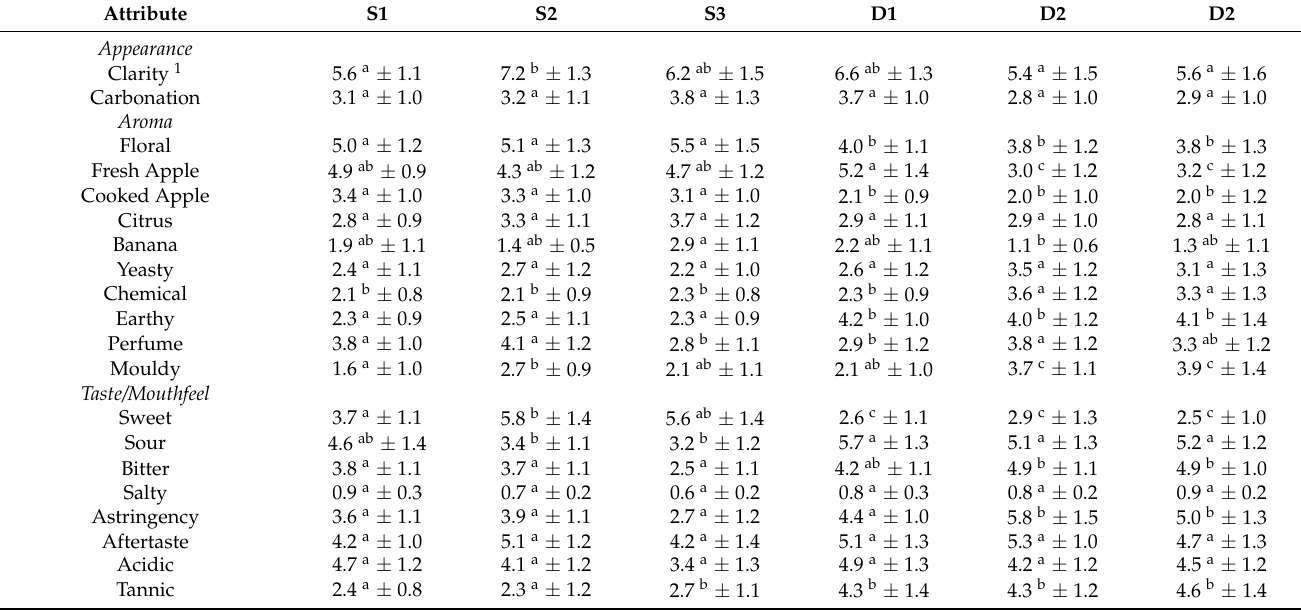
Table 2. Intensities (mean ± standard deviation) of the sensory attributes for the different